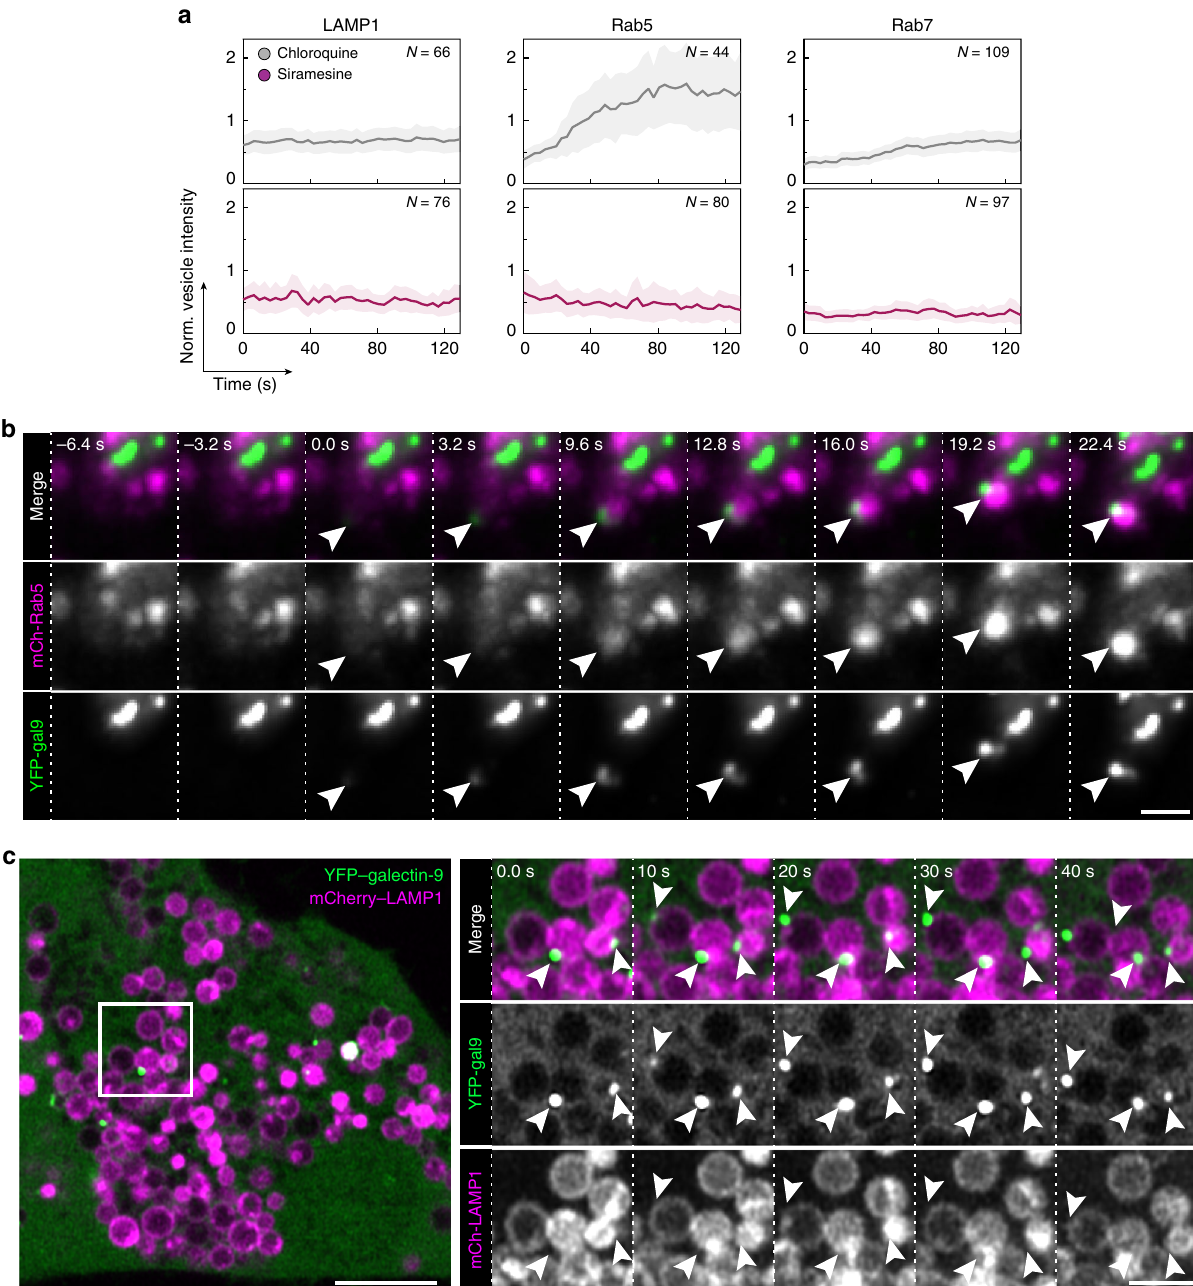
Fig. 7 Galectin-9 assembles on LAMP1 + vesicles during small-molecule treatment. HeLa cells expressing YFP – galectin-9 and the indicated mCherry- tagged endosome markers were treated with chloroquine or siramesine during live-cell microscopy. a The intensity of the indicated endosomal markers measured on vesicles after galectin recruitment. Line is mean, shade is 95% CI. Traces are aligned so that galectin recruitment is fi rst detected at t = 0. N = vesicles, as indicated in the fi gure, from at least two independent experiments. b Wide fi eld microscopy images showing Rab5 recruitment to an endosome shortly after detectable galectin-9 recruitment, indicated by the arrows. Images are representative of two independent experiments. Scale bar, 2 μ m. c Live-cell Airyscan confocal microscopy images of HeLa cells expressing mCherry-LAMP1 during treatment with 100 μ M chloroquine. Arrows indicate galectin-9 foci on LAMP1 + vesicles. Images are representative of two independent experiments. Scale bar, 5 μ m; detail, 2 μ m. Source data for a is presented in a Source Data fi